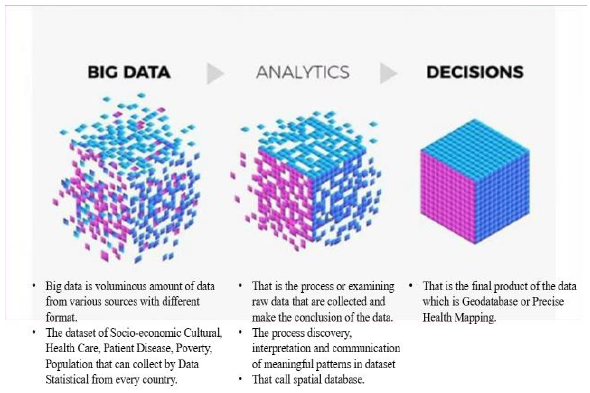
Figure 5. The process of big data collected of TB